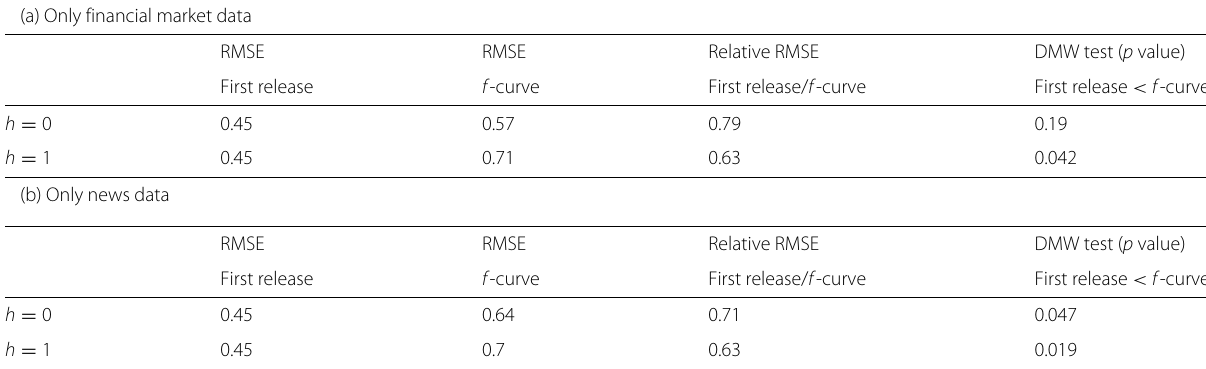
Table 3 Comparison news vs. financial data. Root-mean-squared errors (RMSE) for forecasts on days with a new quarterly GDP release. A lower RMSE implies higher predictive accuracy. h = 0 ( h = 1) denotes the forecast for the current (next) quarter. Panel (a) shows the evaluation for an indicator based only on financial market data. Panel (b) shows the evaluation for an indicator based only on news data. As benchmark, we use the first quarterly GDP release for the corresponding quarter. The Diebold-Mariano-West (DMW) test provides a p value for the null hypothesis of equal predictive accuracy against the alternative written in the column header (Diebold and Mariano 2002; West 1996). We assume a quadratic loss